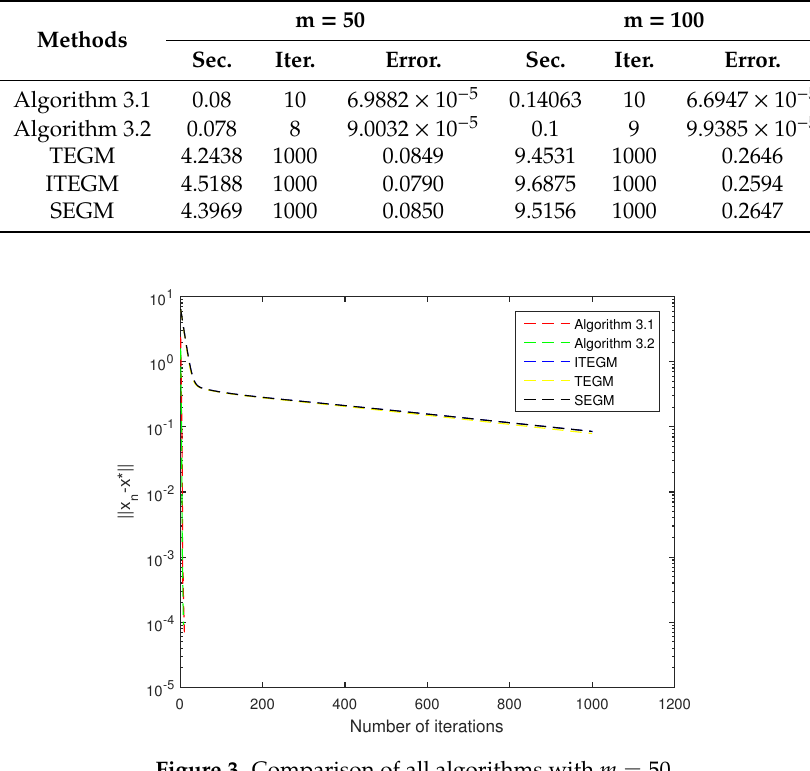
Algorithm 3.1 Algorithm 3.2